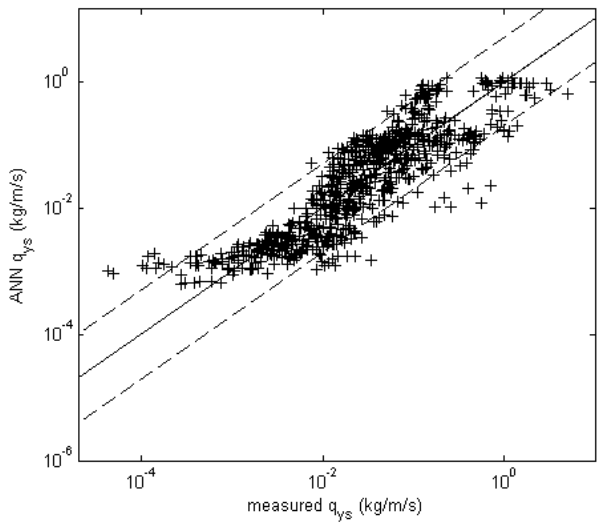
Fig. 5. Comparison of measured and predicted values of depth- integrated suspended sediment transport. Predictions have been made using an ANN with 4 inputs ( H , h , T p , V ) and 4 nodes in 1 hidden layer. The solid line indicates equality and the dashed lines indicate a factor 5 difference between the predicted and observed values.